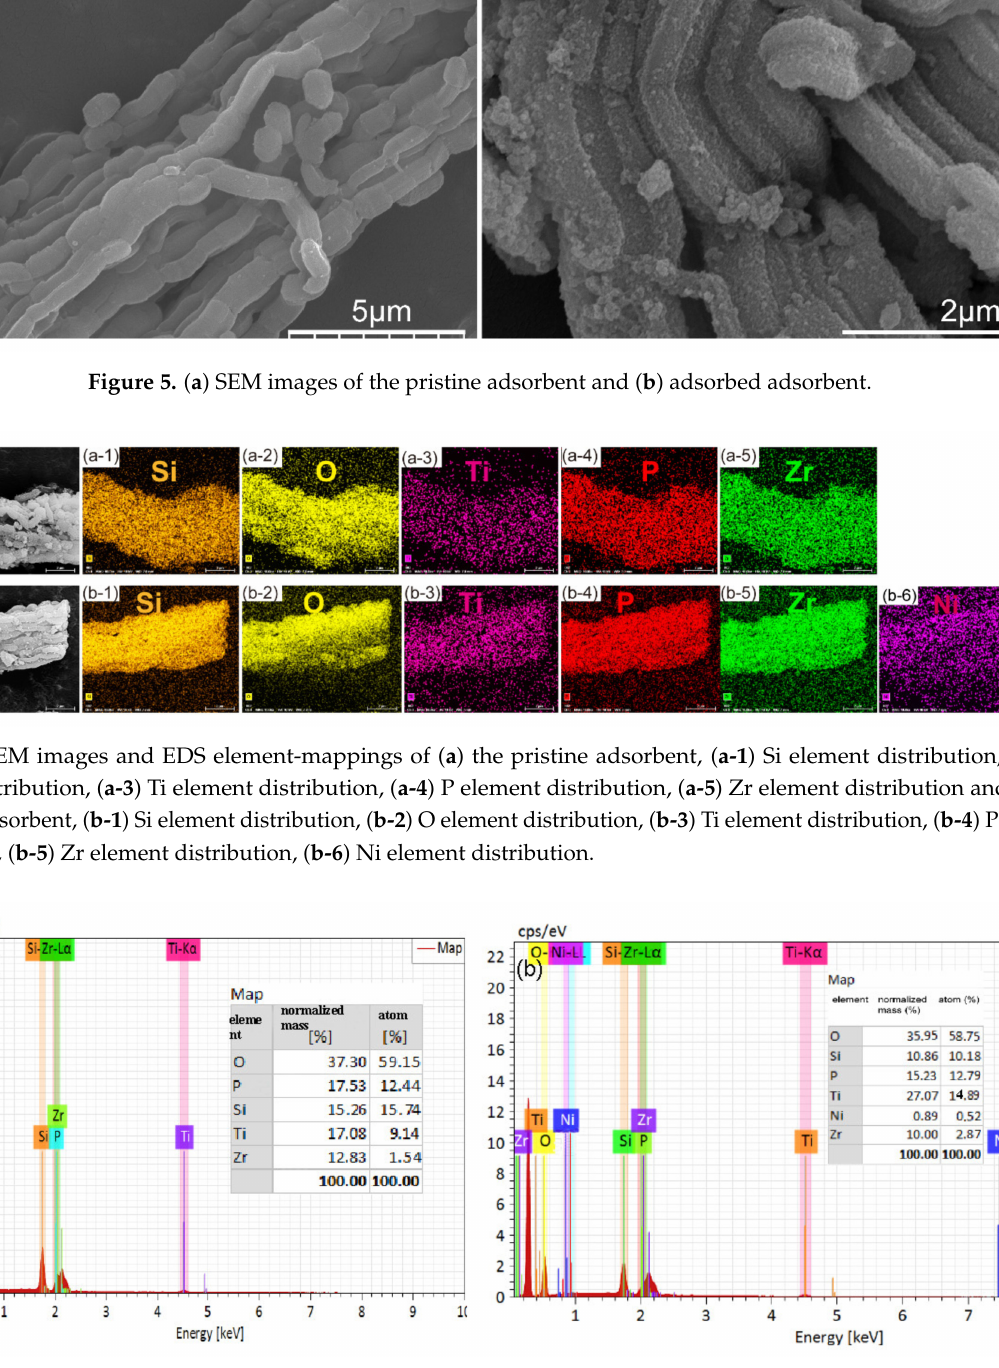
Figure 7. The atom percent of the elements ( a ) O, P, Si, Ti, Zr and ( b ) Si, O, Ti, P, Ni,